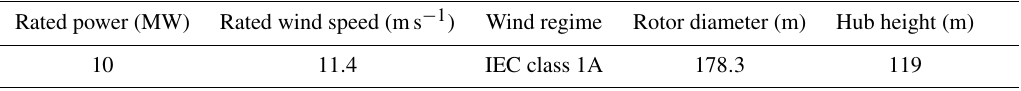
Table 1. Main properties of the DTU 10MW reference wind